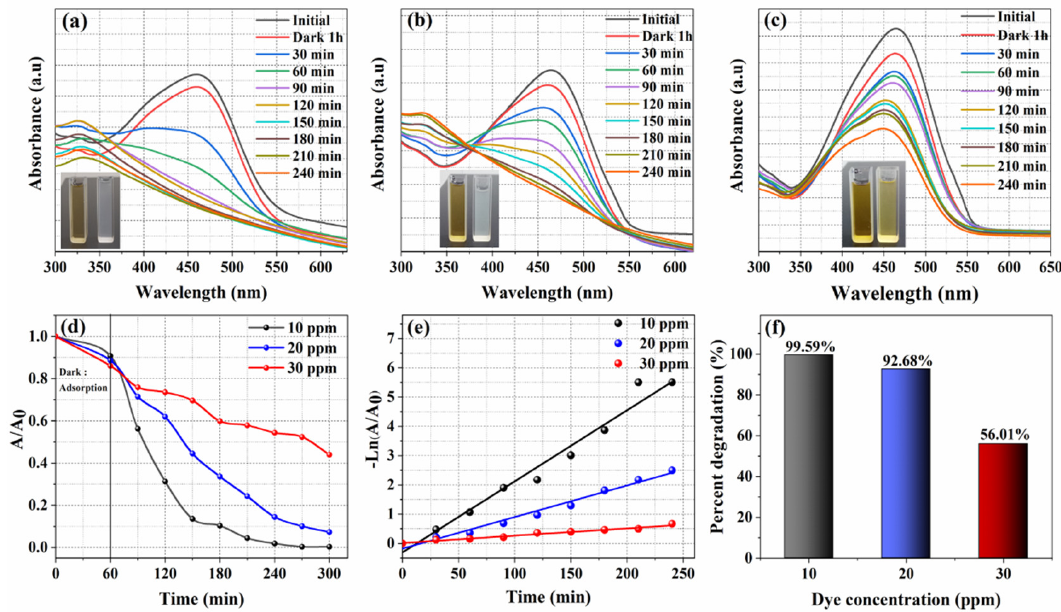
Figure 8. Concentration study of methyl orange. Spectrophotometer spectra at different time intervals and methyl orange concentrations ( a ) 10 ppm, ( b ) 20 ppm and ( c ) 30 ppm. The dose of the PAN_Coa NFs membrane was kept constant (60 mg), ( d , f ) degradation and ( e ) kinetics.